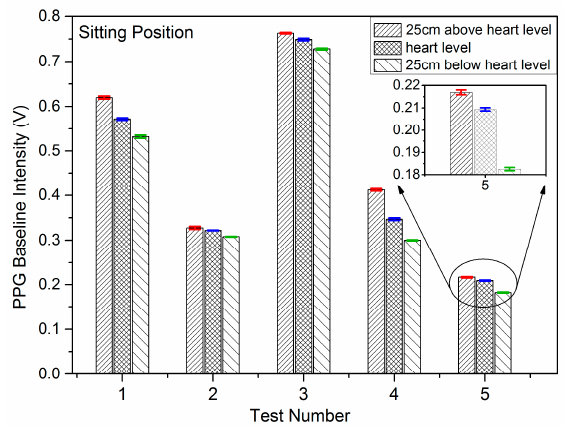
Figure 6. PPG baseline intensities and standard deviations when the subjects were in the sitting position and the finger sensor probe set at three different vertical levels.